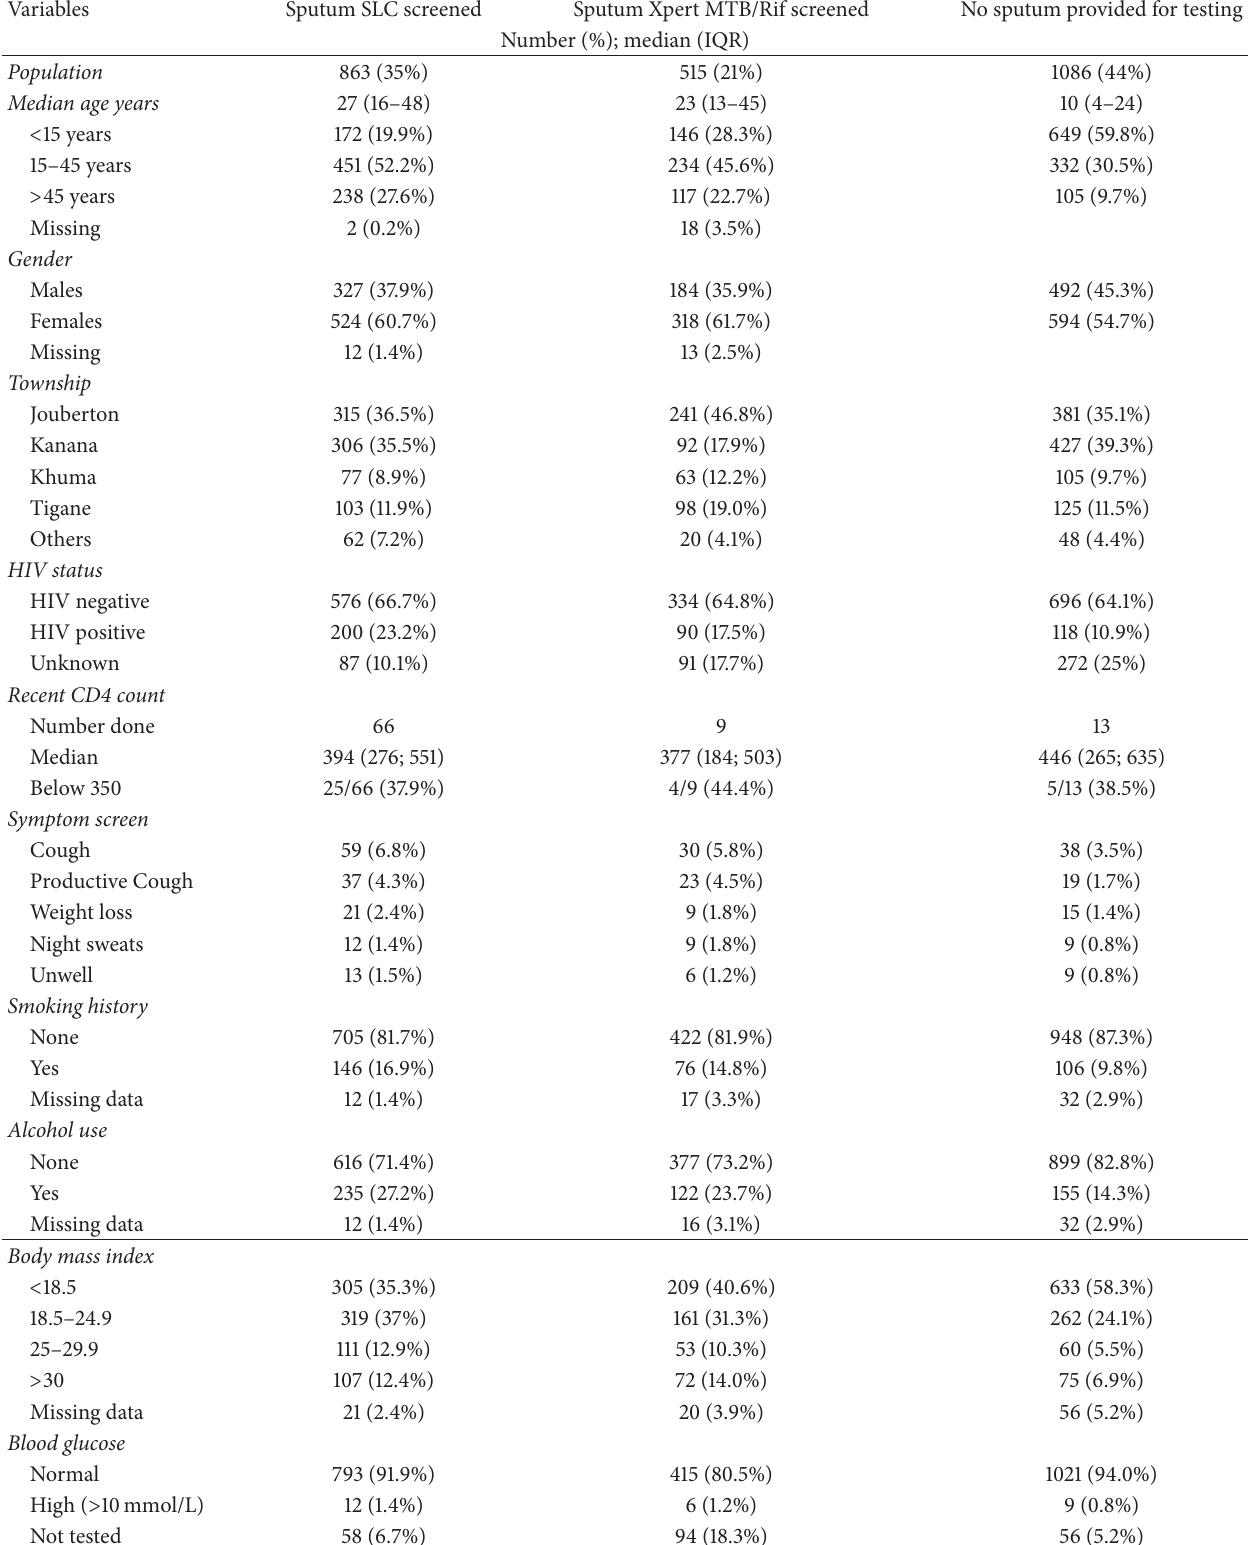
Table 2: Characteristics of household